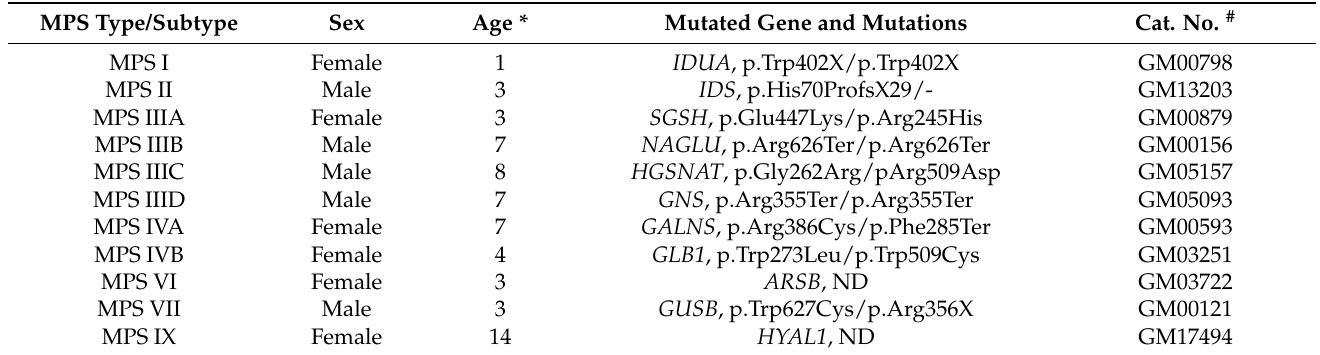
Table 2. Characteristics of MPS patient-derived fibroblast lines (based on ref. [16], with permission of the